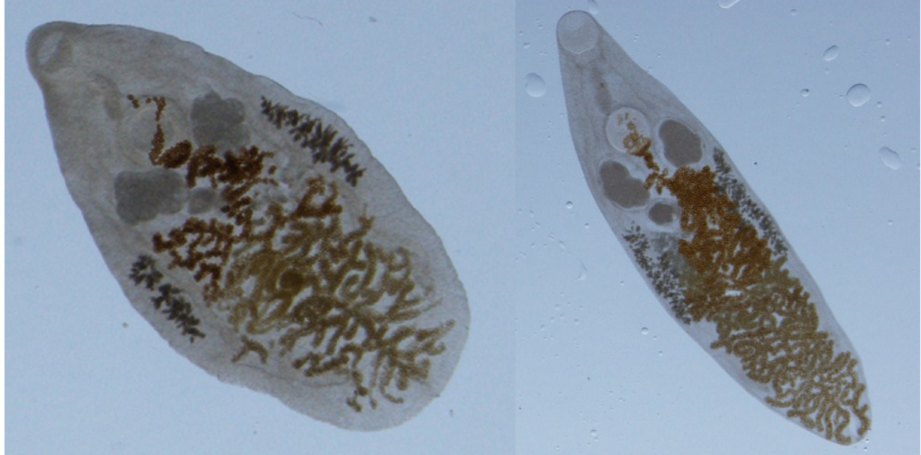
Figure 1. Adult Platynosomum fastosum harvested from the liver of a cat.